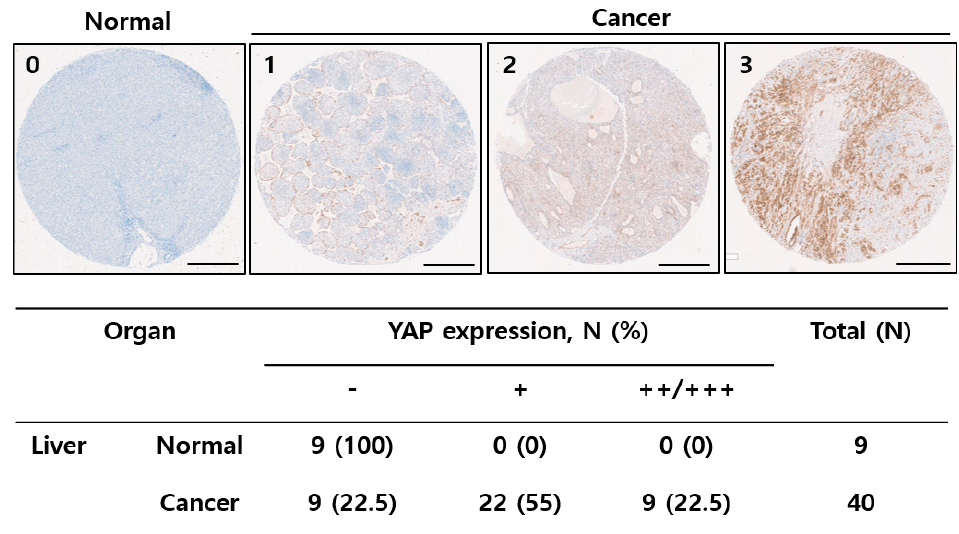
Figure 1. YAP expression in liver tissues and its counterparts. Cancer patient-derived microarrays containing HCC and normal tissues were examined for YAP expression. Scale bar = 500 µ m. YAP expression was scored according to the intensity and proportion of positive cells, and representative immunohistochemical images of YAP are shown; none (-), weak (+), moderate (++), or strong (+++). The staining results show the summarized expression of YAP in normal ( n = 9) and tumor tissues ( n = 40).